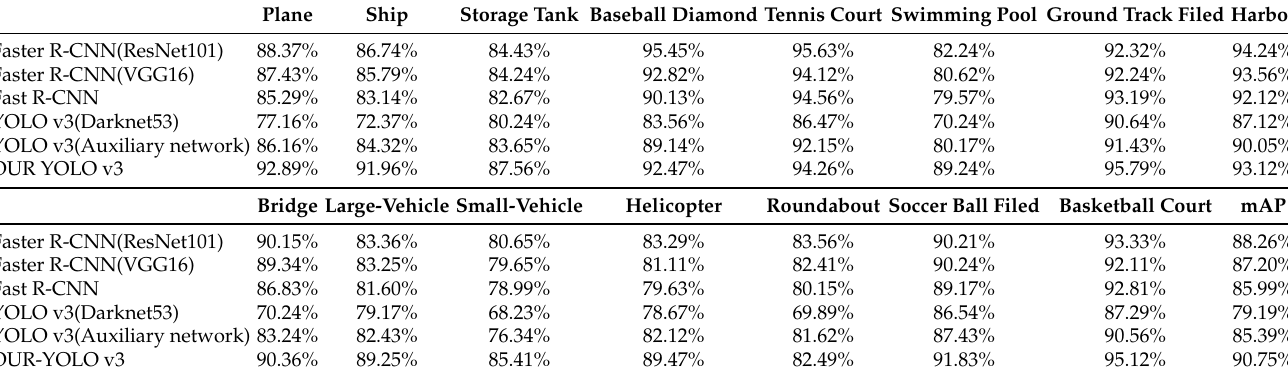
Table 2. Target detection accuracy of each category on the DOTA dataset (%).